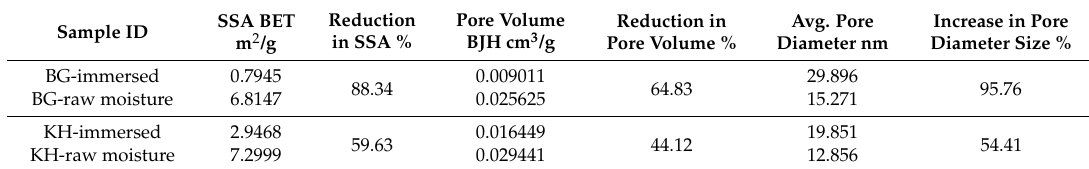
Table 3. Comparative pore system parameters of the raw moisture and water immersed samples.